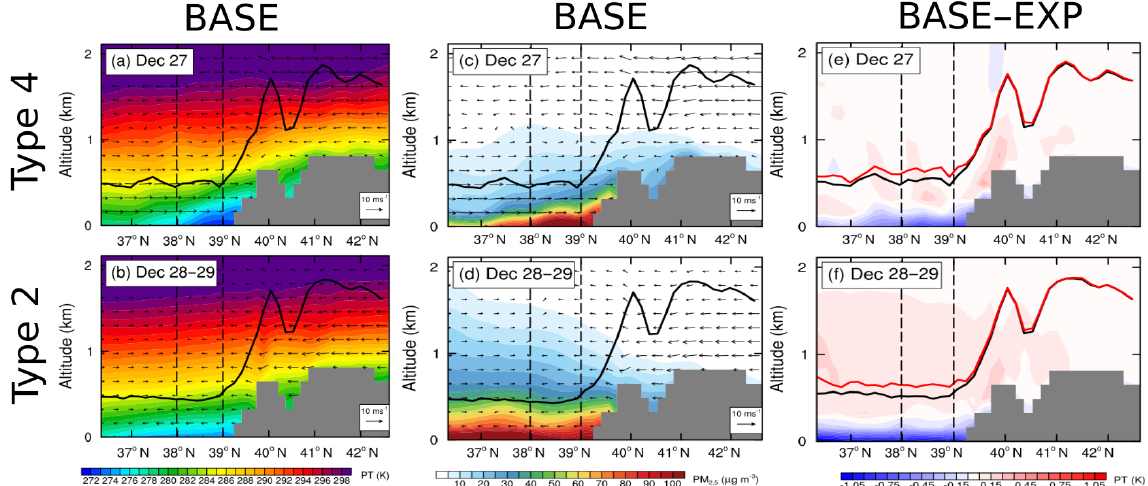
Figure 10. Vertical cross sections of simulated (a, b) PT, (c, d) PM 2 . 5 concentration, and (e, f) concentration perturbations induced by the aerosol radiative effect from 09:00 to 16:00BJT on (a, c, e) 27 December and (b, d, f) 28–29 December . The locations of cross sections are indicated by the black lines in Fig. 9. In (e, f) , the BLH of the BASE run is denoted by the black lines and the BLH of the EXP run is denoted by the red lines. Note that the vertical velocity is multiplied by a factor of 10 when plotting the wind vectors. The dashed vertical lines indicate the regions used to derive the profiles of PT and PM 2 . 5 concentration shown in Fig.